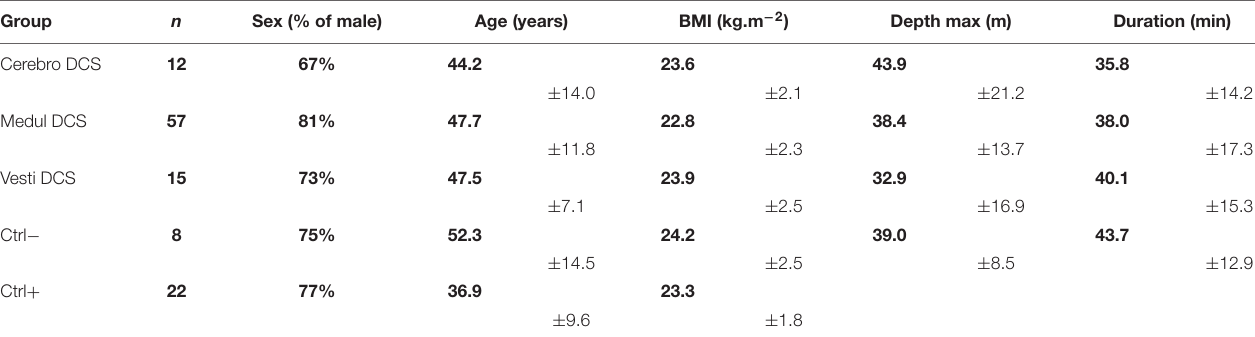
TABLE 1 | Description of the